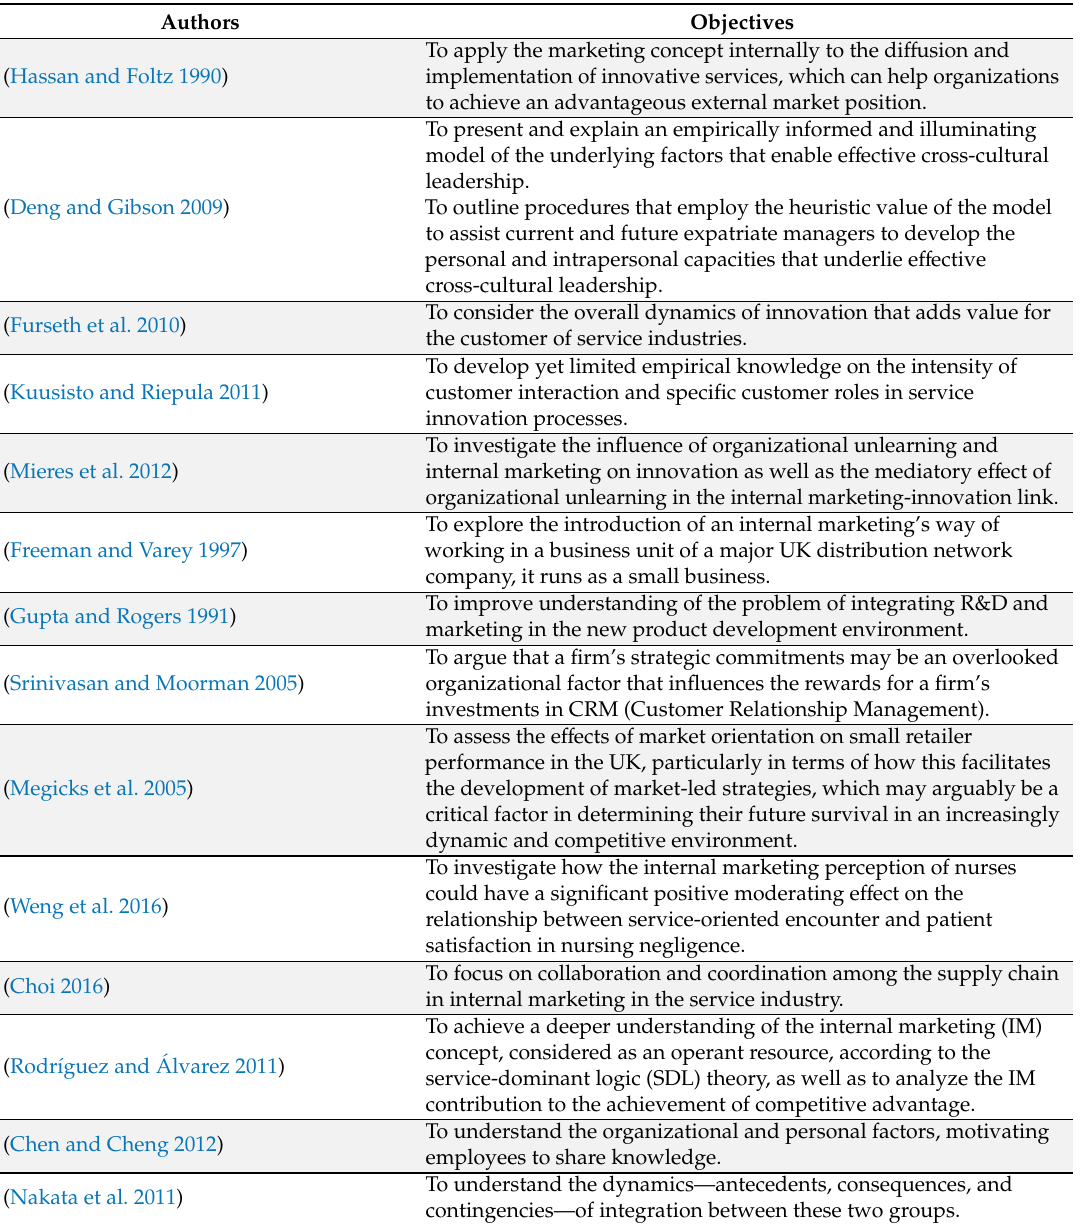
Table 2. Objectives from selected literature